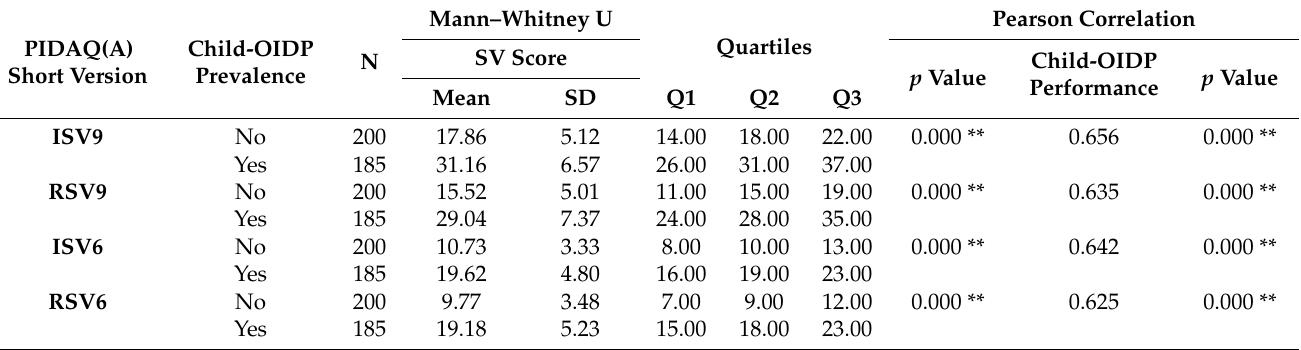
Table 9. The criterion validity: correlations of all PIDAQ(A) short versions and Child-OIDP question- naire (n = 385).